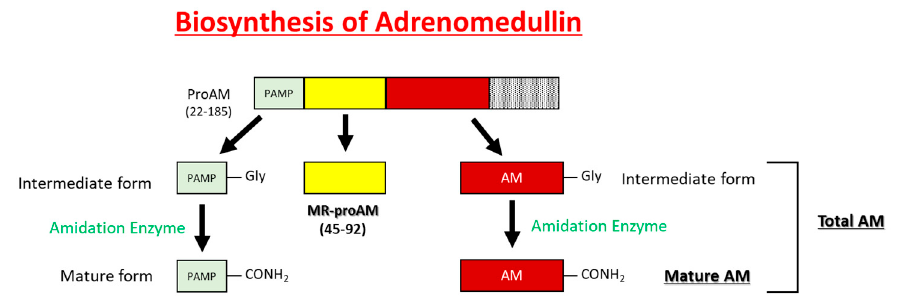
Figure 2. Schematic representations of the processing of AM, MR-proAM, and PAMP from proAM.